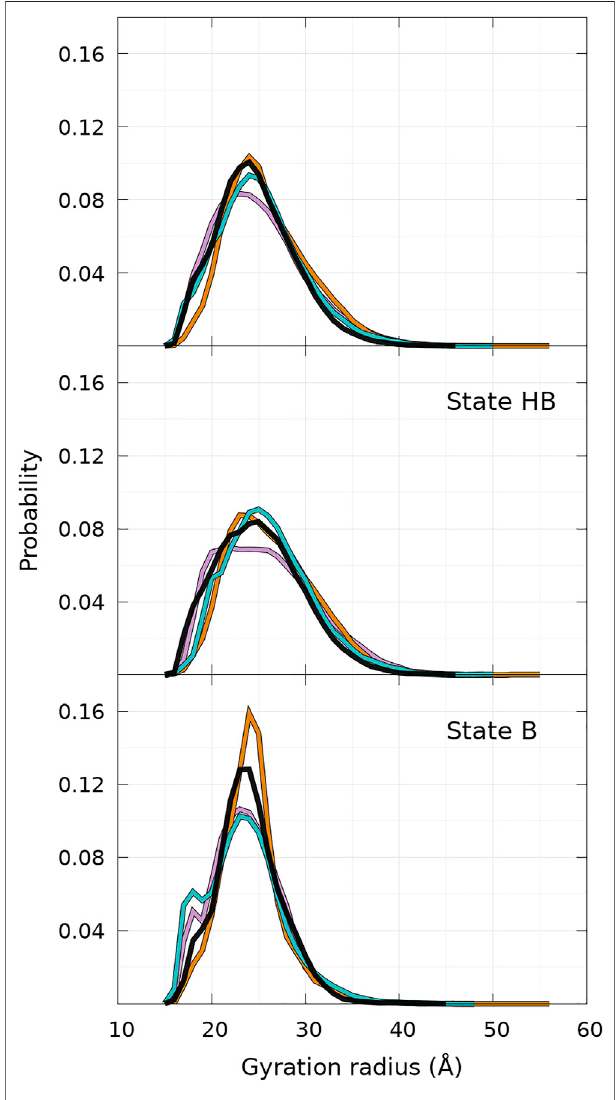
FIGURE 7 | Probability density of gyration radius computed for WT and mutants of α -syn for the complete conformational ensemble (top panel), the ensemble of state HB (middle panel), and the ensemble of state B (bottom panel) . The color code is WT (black), A30P (purple), E46K (turquoise), and A53T (orange). State B represents 40% of conformations for WT, A30P, and E46K and 25% for A53T (see text).